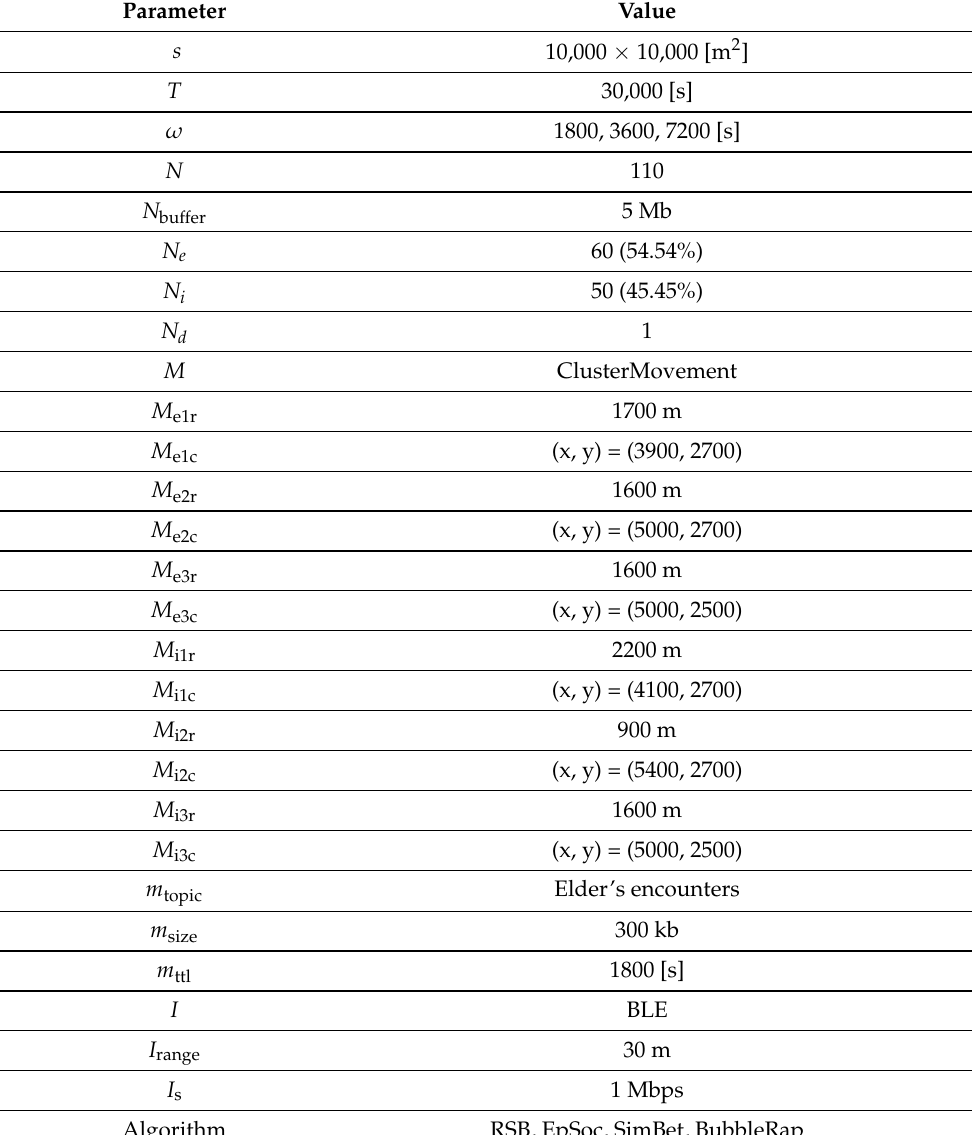
Table 1. Variables and distribution in the simulated